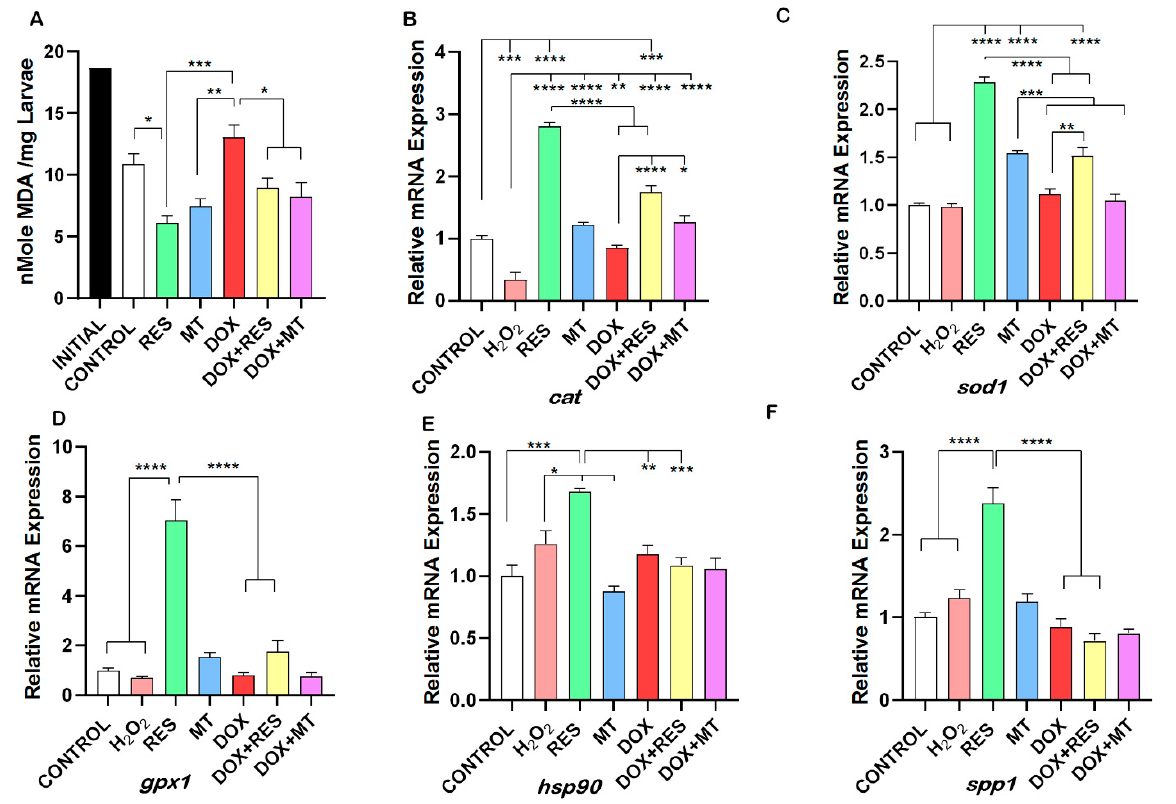
Figure 8. Oxidative stress and antioxidant status on antioxidant and pro-oxidant treatment. Lipid peroxidation of the gilthead seabream larvae feed with antioxidant and pro-oxidant diets, initial- initial larvae of 20 days ( A ). mRNA expression of expression of antioxidants genes on VSa13 cells treated with Antioxidants and Pro-oxidants (Resveratrol, MitoTEMPO, Hydrogen peroxide and Doxorubicin); Catalase ( cat ) ( B ), superoxide dismutase 1 ( sod1 ) ( C ), glutathione peroxidase 1 ( gpx1 ) ( D ), heat shock protein 90 kDA alpha 1 ( hsp90 ) ( E ) and osteopontin ( spp1 ) ( F ). One-way ANOVA, Tukey’s multiple comparisons test, *— p ≤ 0.05, **— p ≤ 0.01, ***— p ≤ 0.001, and ****— p ≤ 0.0001. Acronyms: Resveratrol (RES), Doxorubicin (DOX), MitoTEMPO (MT), doxorubicin + resveratrol (DOX+RES), doxorubicin + MitoTEMPO